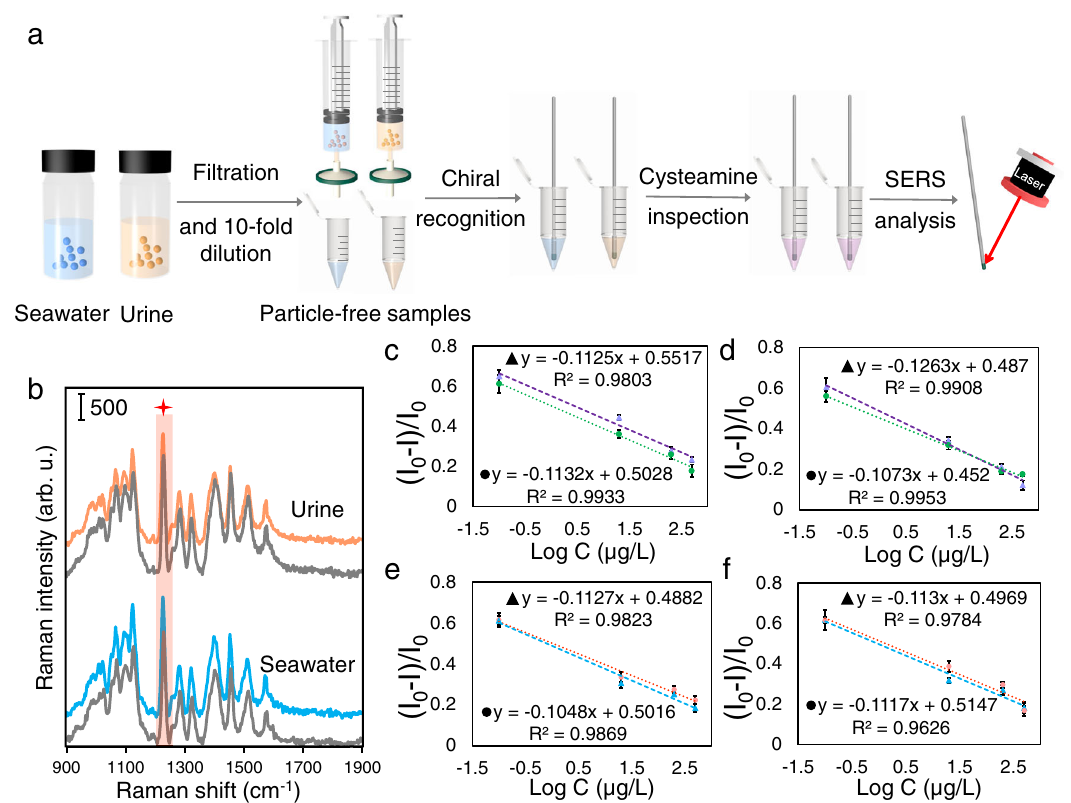
Fig.8|Real-worldapplicationofSERS-CIP.a Schematicillustrationofreal-sample analysis by the SERS-CIP based on IRM. b Raman spectra of DTTC on the SERS tag@capillarybefore(grayspectra)andafter(blueand orange spectra)incubation incrudeseawaterandurinesamples.Linearrelationship betweentherelativeSERS intensity (( I 0 − I )/ I 0 ) of c , e asparagine-SERS-CIP and d , f galactose-SERS-CIP and the logarithm of enantiomers concentration in the samples. I 0 and I are the SERS